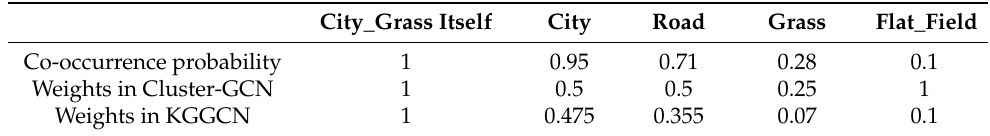
Table 5. Comparison of weights in Cluster-GCN and